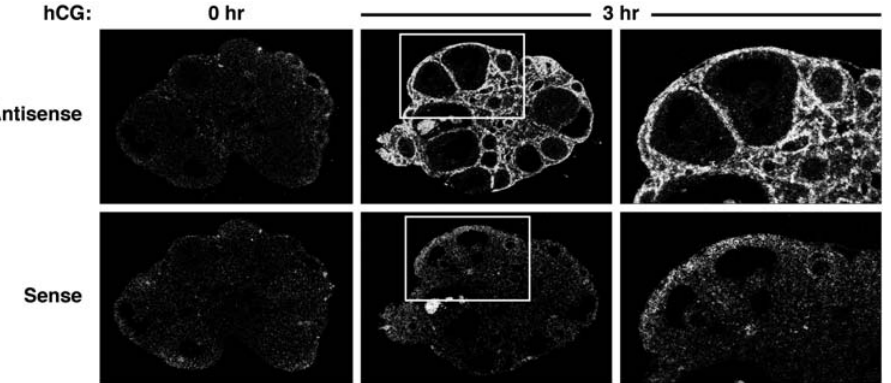
Figure 3. CebpdmRNA expression is localized to theca and interstitial cells. Dark-field photomicrographs of in situ hybridization analyses using Cebpd -specific sense and antisense RNA probes on sections from ovaries of 6 week-old mice treated for 2 days with PMSG followed by hCG for the indicated times. Outlined regions in the center panels are shown at higher magnification on the right.